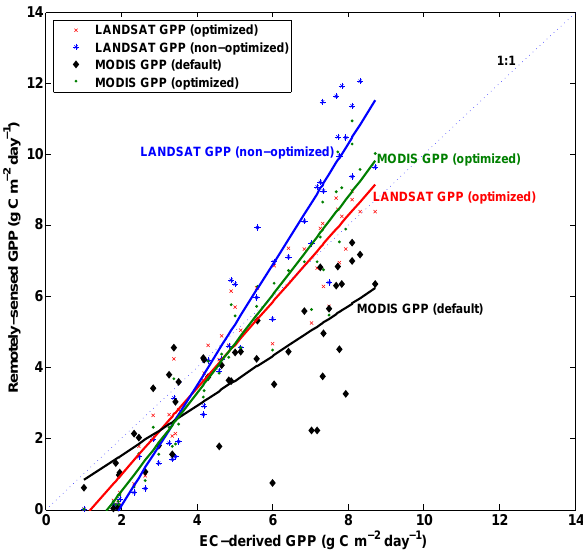
Fig. 8. Differences in estimated annual total gross primary pro- duction (GPP) using the VPM model – between, without and with the optimized footprint integrated algorithm (non-optimized – opti- mized) based on the synthetic LANDSAT-like images in 2004 in an evergreen needleleaf forest over a 30km × 30km region centered at QYZ, China.